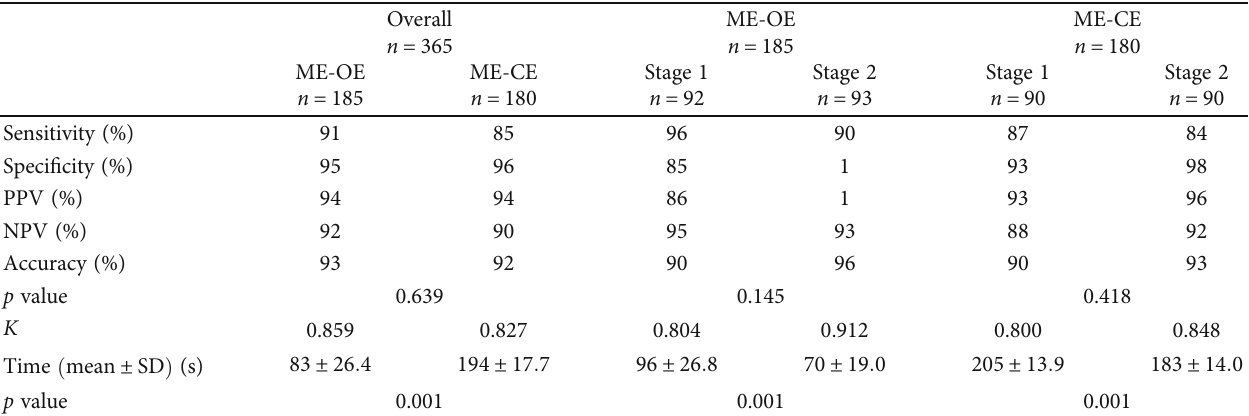
Table 3: Diagnostic accuracy and time in two